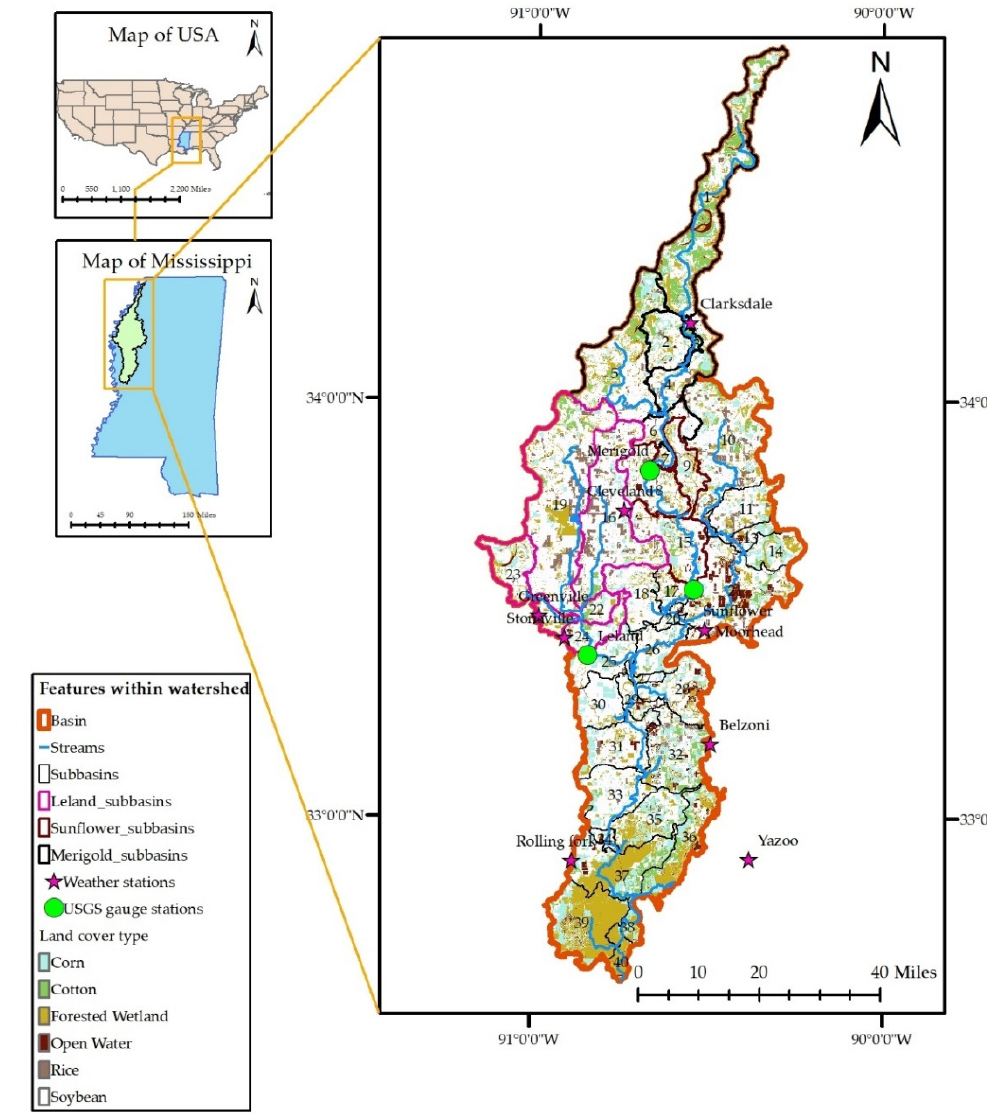
Figure 1. Location map of Big Sunflower River Watershed with landcover, weather stations, USGS gauge stations, streams, and subbasins.